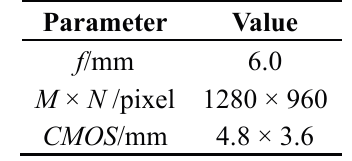
Figure 5. Topology of the experiment. Table 1. Intrinsic parameters of